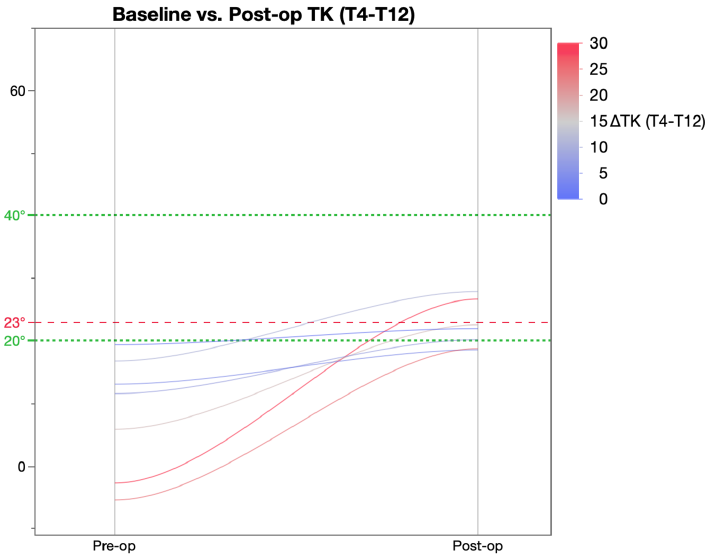
Figure 2. Pre and post-op kyphosis in patients with baseline TK less than 20 degrees.